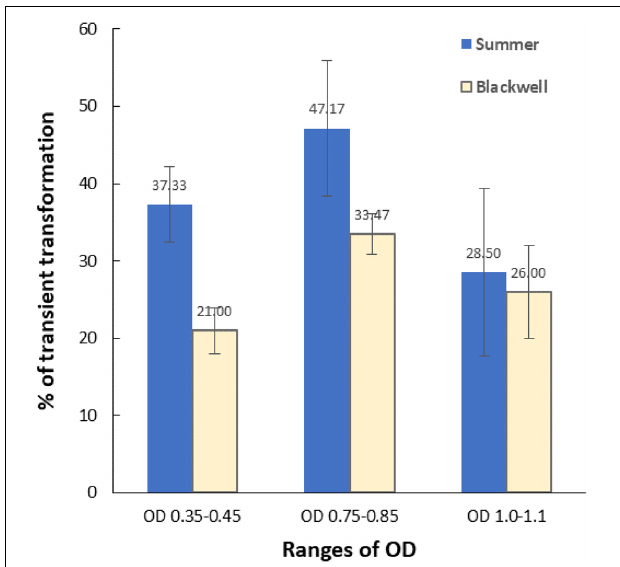
FIGURE 6 | The effect of the optical density (OD 650 ) of Agrobacterium culture (LBA4404Thy-) on transient transformation frequencies. X-axis, three ranges of OD; Y-axis, percent of immature leaf segments emitting GFP signals. Vertical bars associated with each data point is the standard deviation representing three experiments. Detection of GFP was carried out using a Zeiss fluorescence microscope 5–7 days after Agrobacterium